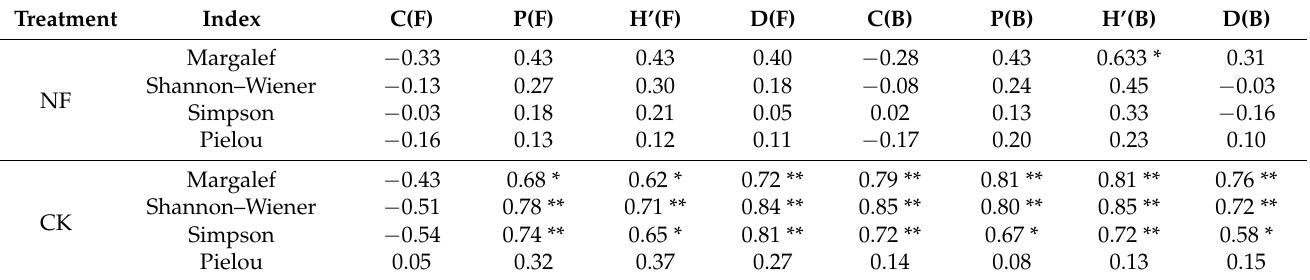
Table 3. Correlation analysis of plant diversity with microbial diversity under main land-use